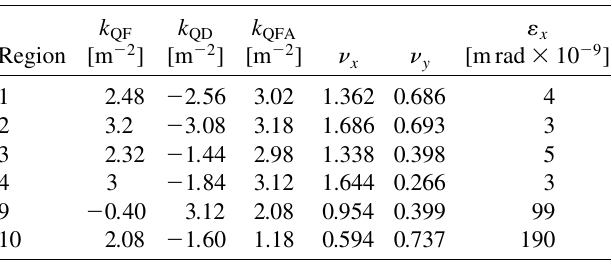
TABLE I. Lattice parameters for displayed ALS lattices.